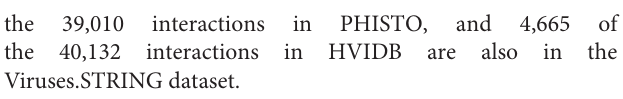
FIGURE 5 | Structure of the virus-host protein–protein interaction network for the Viruses.STRING dataset and overlapping proteins and interactions in the EBI-GOA-nonIntAct, BioGRID, VirusMentha, IntAct, VirHostNet, HPIDB, HCVpro, VirusMINT, PHISTO, and HVIDB datasets (gray). Proteins overlapping only with IntAct are shown in red, proteins overlapping only with VirHostNet in green, and proteins overlapping only with BioGRID in